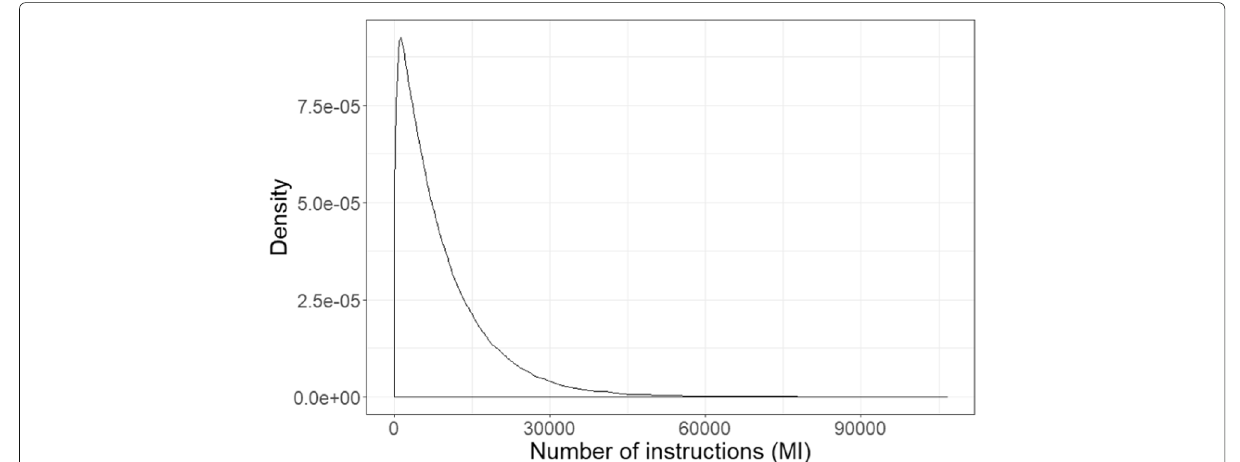
Fig. 17 Density function of the number of instructions per task in the theoretical